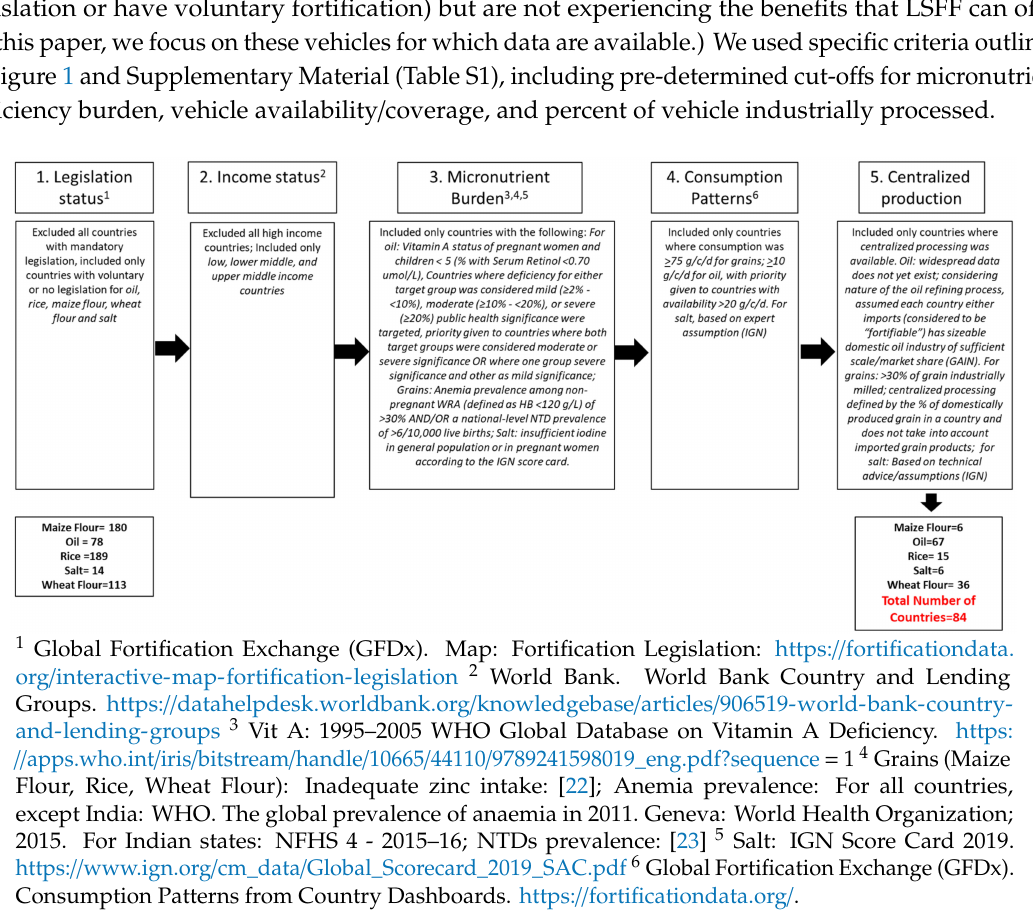
Figure 1. Criteria the selection of Low- middle-, and upper-middle income countries that have potential to benefit from new LSFF programs or making voluntary programs